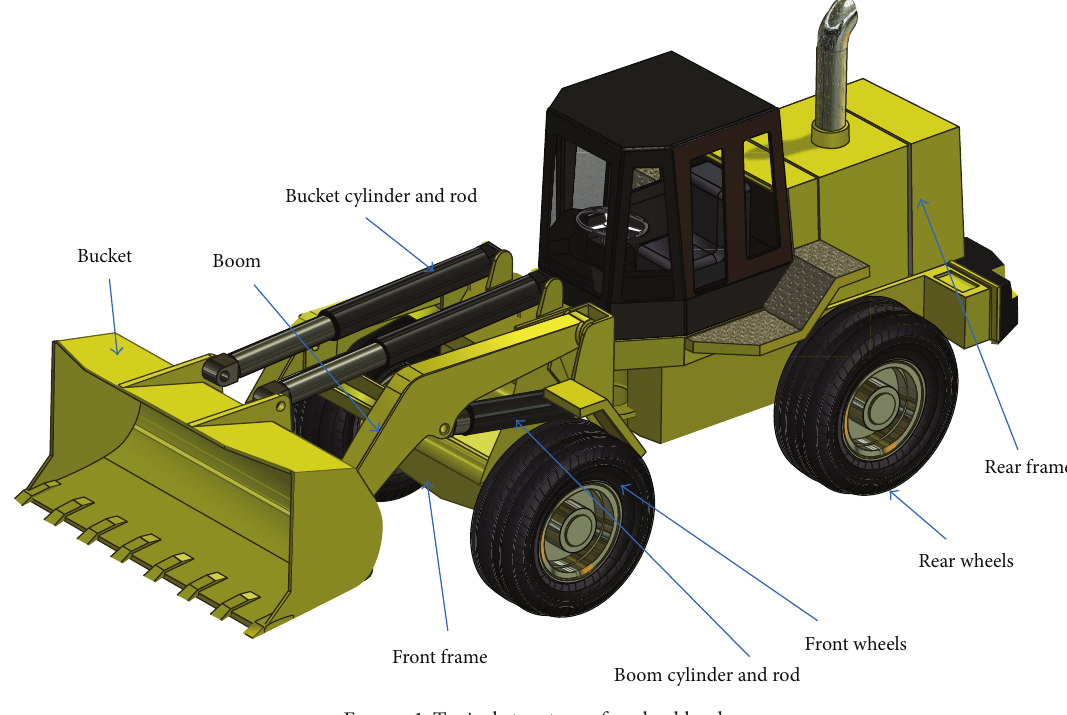
Figure 1: Typical structure of a wheel loader.